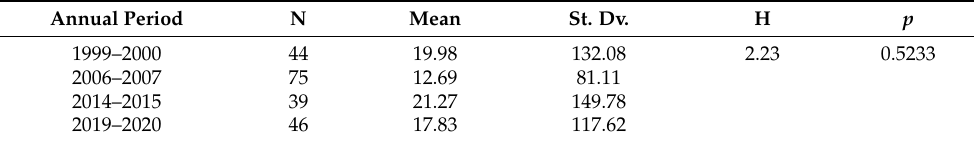
Table A11. Area’s Kruskal Wallis tests between time periods for the Santo Tom é district.